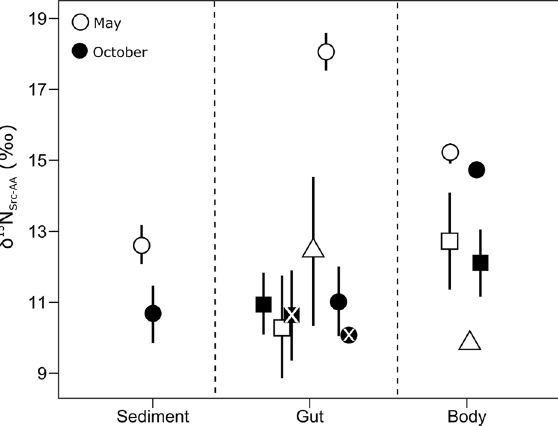
Figure 3. δ 15 N values of “source” AAs (δ 15 N Src-AA ; mean ± SD) of surface sediments (0–5 mm), gut contents and body tissue collected in the period of low food supply (i.e. May; open symbols) and in the period of high food supply (i.e. October; closed symbols). Gut contents (frontgut: crossed symbol; hindgut: plain symbol) and body tissue correspond to species of deposit feeders: O. mutabilis (squares), S. globosa (triangles) and E. rostrata